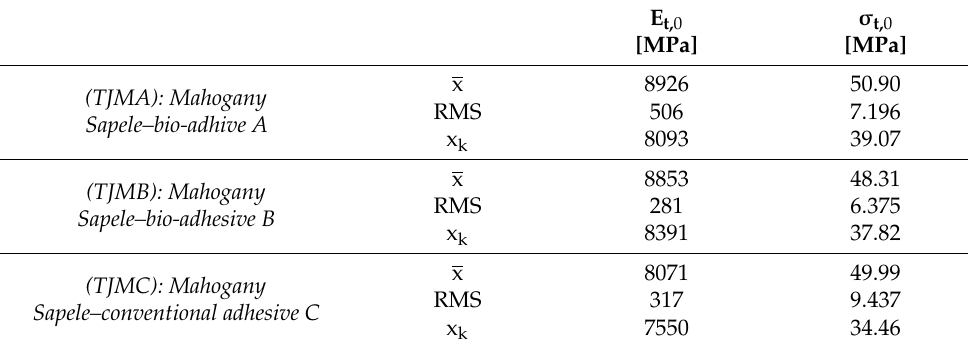
Table 5. Results for Mahogany Sapele scarf-joint tensile